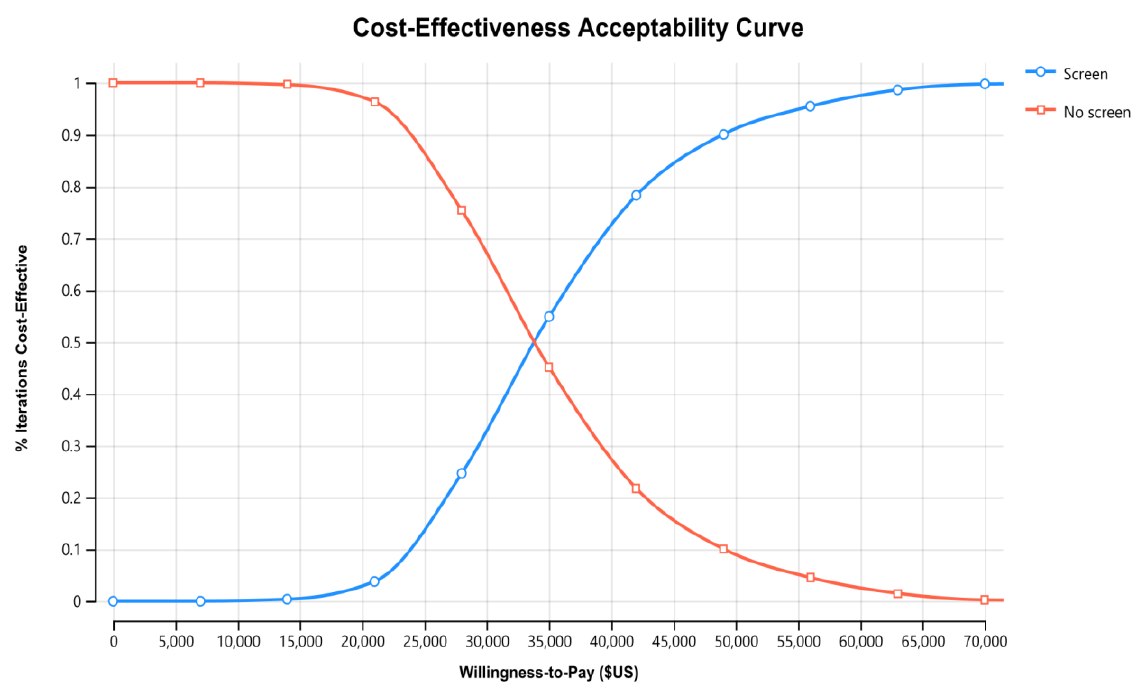
Figure 3. Cost-effectiveness acceptability curve for SCID NBS, government perspective, 60 years, discounted US$ (d = 3% p.a.). Note: At the willingness-to-pay threshold of US$35,000 per QALY, the percentage of simulated ICERs of screen (blue line) is about 55%, whereas at the willingness-to-pay threshold of US$50,000 per QALY, the screen intervention (blue line) has 90% chance and above to be cost-effective.